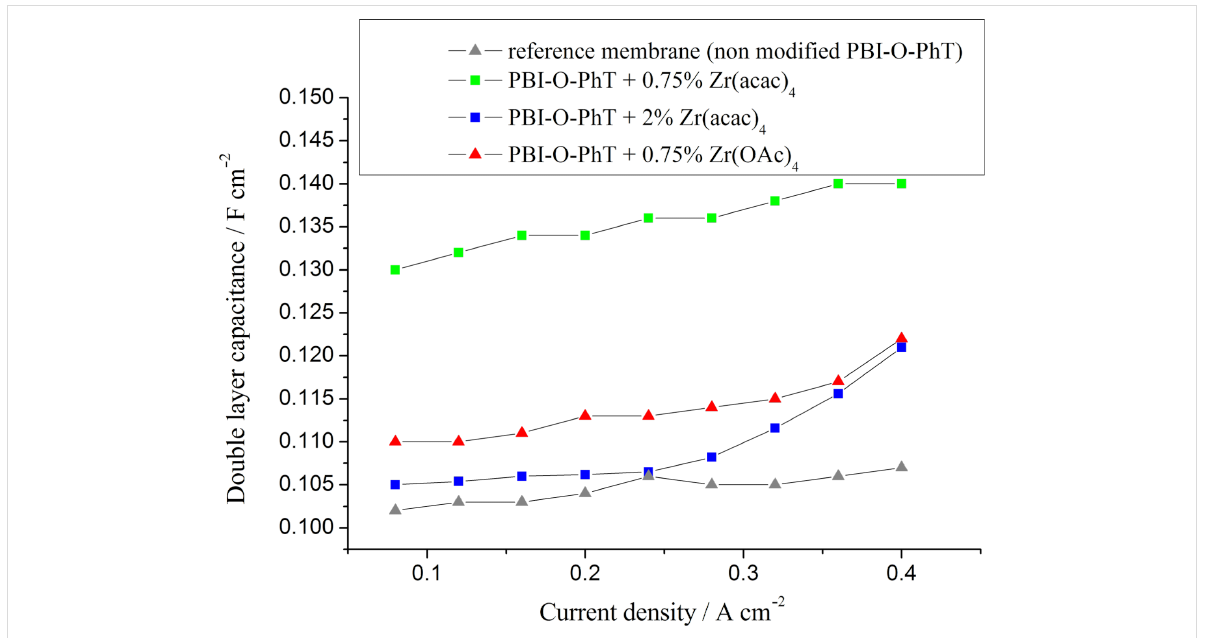
Figure 12: The double layer capacitance as a function of the current density for fuel cells with different PBI membranes ( T = 160 °C). A higher capa- citance indicates a higher area of interphase boundary (PA/Pt and C), which depends on the amount of PA in the active layer.